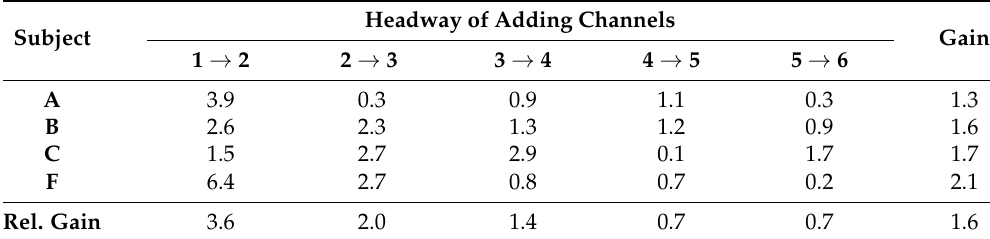
Table 10. Classification accuracy gain achieved after adding channels for each subject.